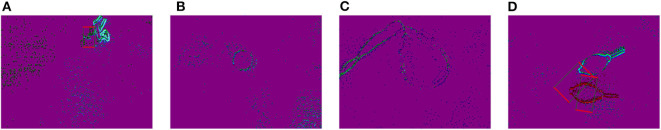
Failed detection cases: (A) detection of failure; (B,C) no detection results at a threshold; and (D) an anomaly in the event sensor causes a detection error.